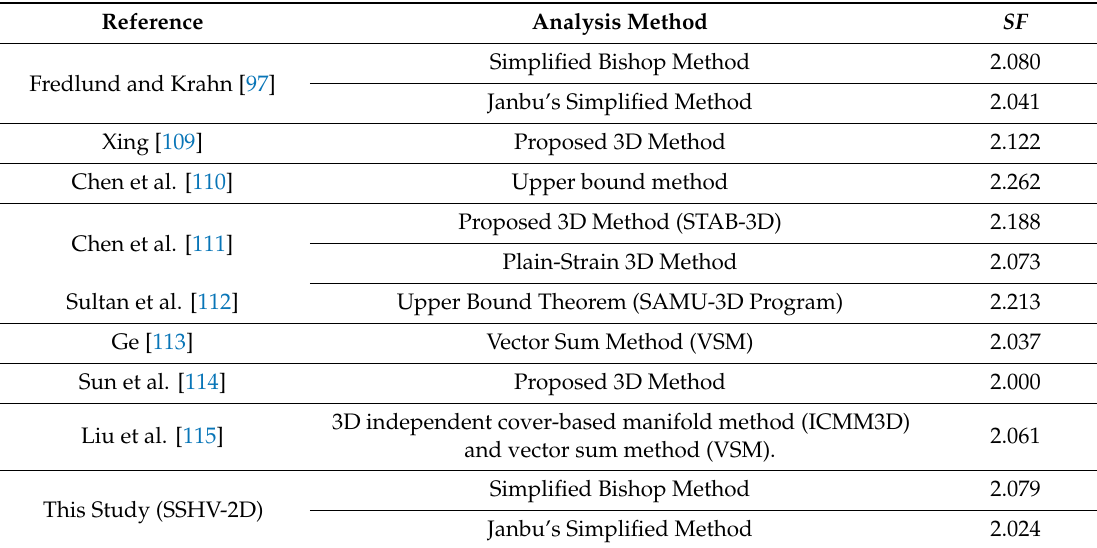
Figure 13. Homogeneous slope studied by Fredlund and Krahn [97]. Table 7. Reported safety factors for homogeneous slope (Case